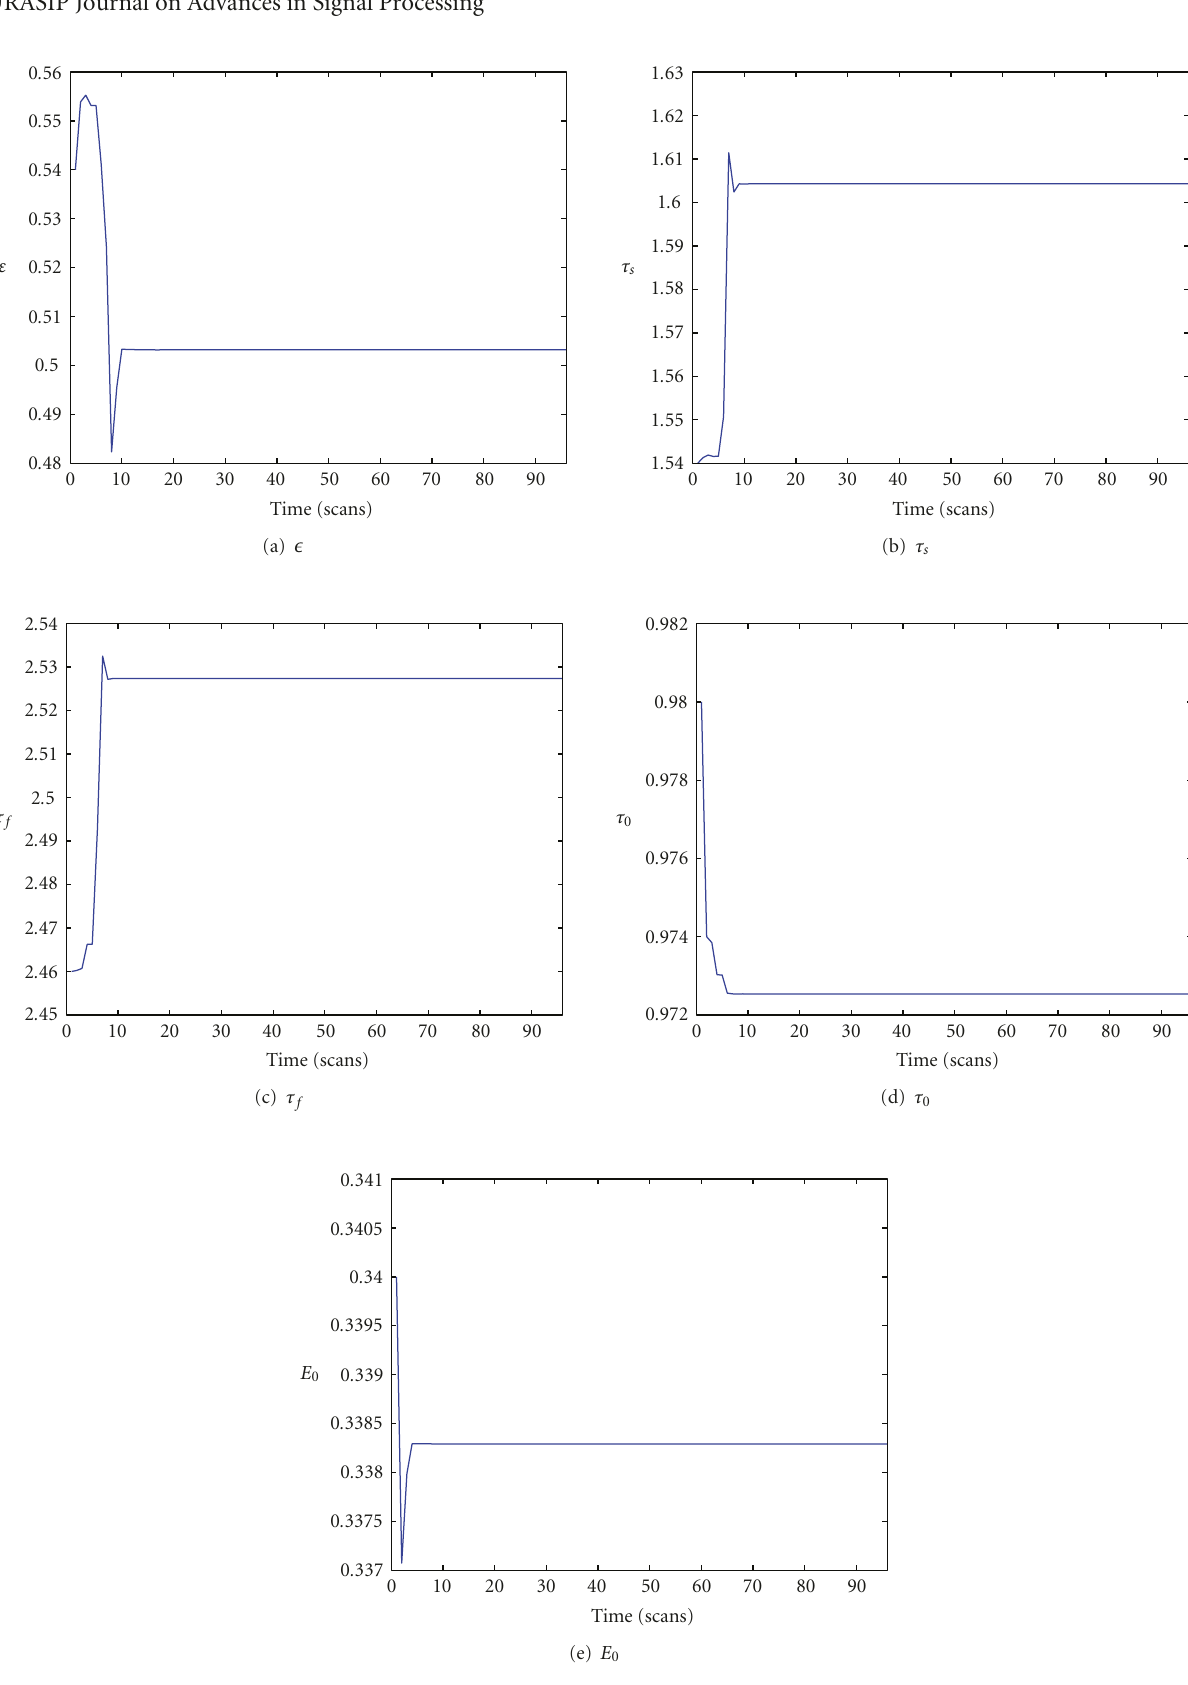
Figure 8: Convergence of parameter